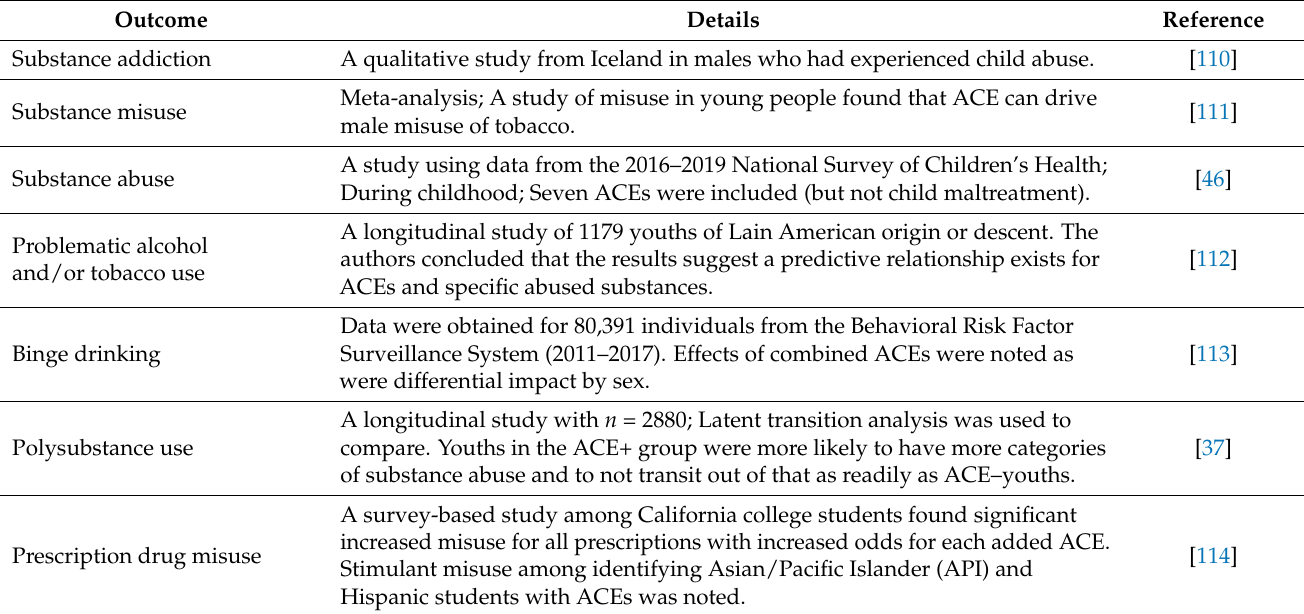
Table 4. Recent Examples of ACE and Substance